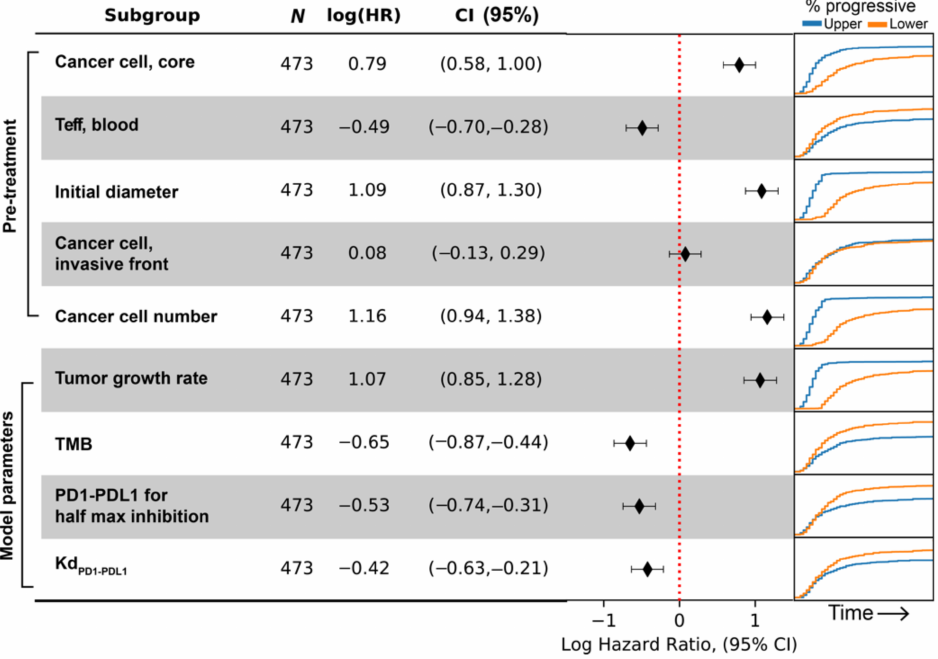
Figure 11. Hazard-ratio of progression in patient subgroups based on indicated biomarkers. On the right-hand side, the proportion of patients whose tumor have progressed is plotted against time after treatment started. Blue and orange corresponds to the upper and lower half of the virtual population with regard to each